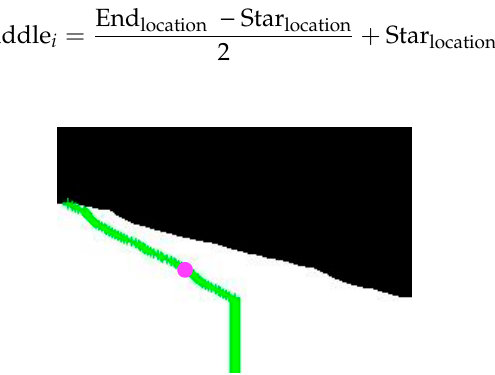
Figure 7. The resulting middle point estimation for path calculation.